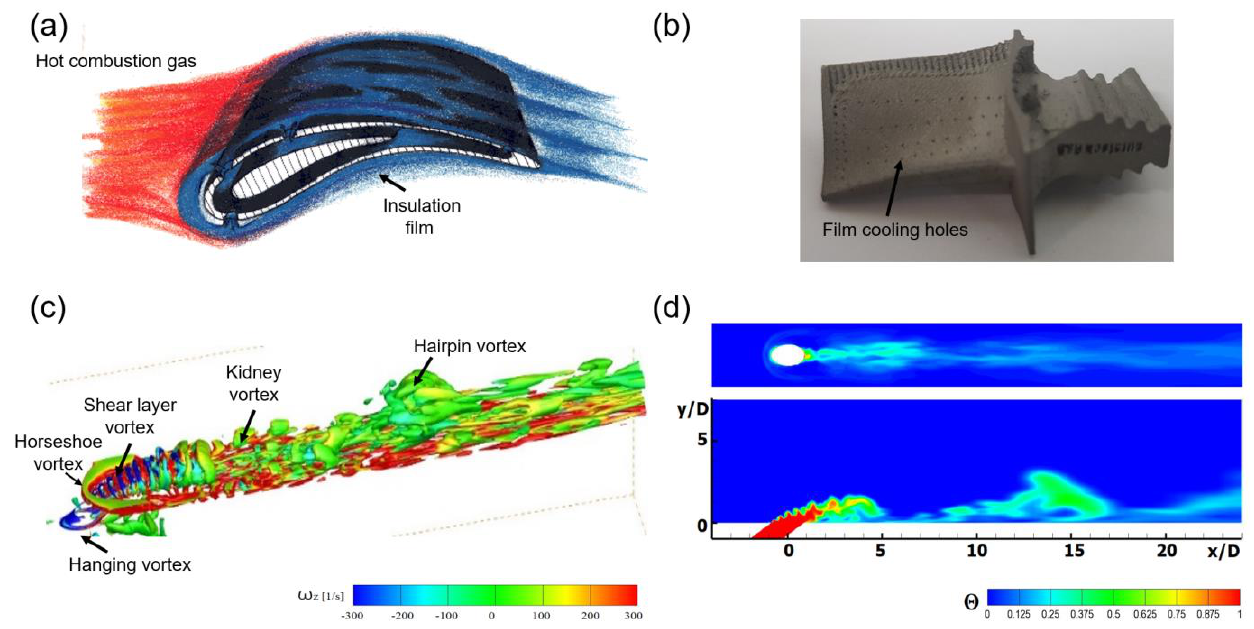
Figure 1. Film cooling of a gas turbine: ( a ) schematic of film cooling, ( b ) gas turbine blades with film-cooling holes installed [5], ( c ) flow structure of the film-cooling jet [6], and ( d ) instantaneous temperature field of film cooling [6].